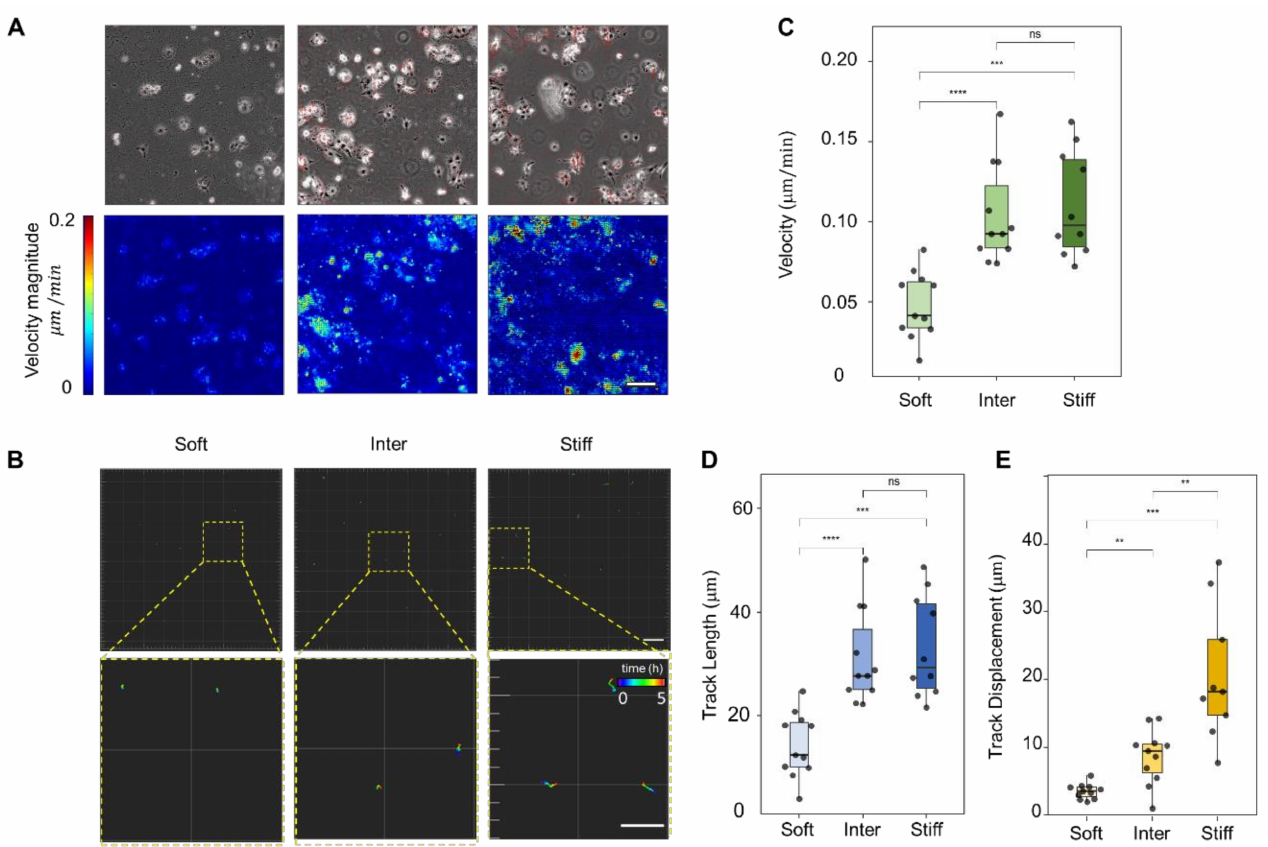
Figure 3. Stiff simulated ECM enhances JAR cell motility ( A ) ( Top ): Vectors of JAR cell migration. ( Bottom ): heatmap of velocity magnitude on different regions of simulated ECM (scale bar: 50 µ m, color bar: 0~0.2 µ m/min). ( B ) Tracking of JAR cells cultured on different regions (scale bar: 100 µ m, time bar: 5 h). Each scatter indicated each cell being analyzed. ( C , D ) Velocity and track length